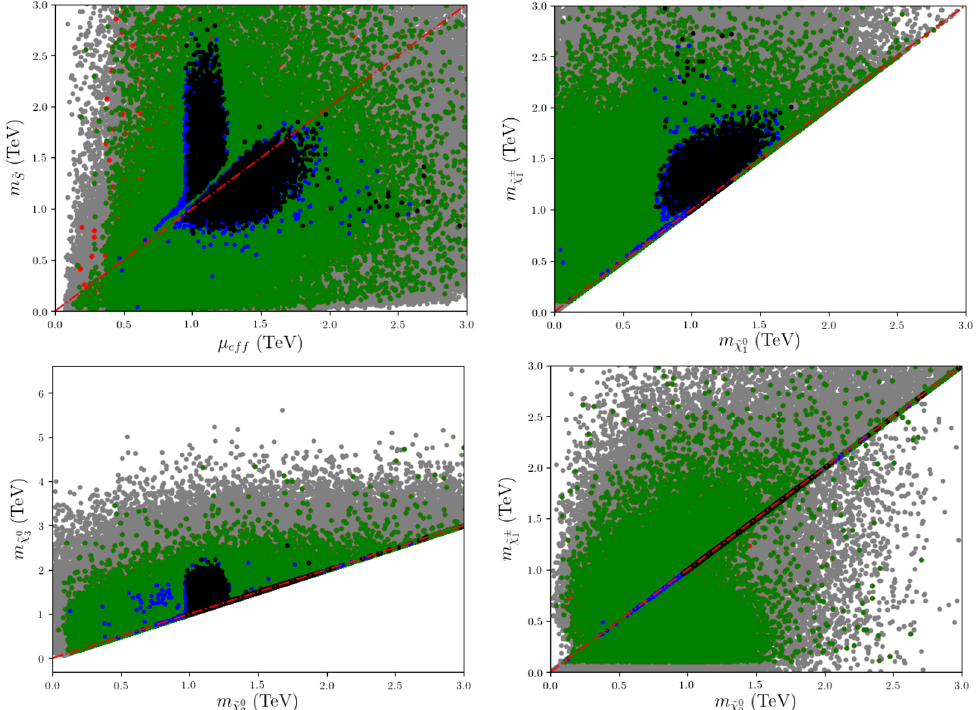
Figure 5 . The mass spectrum of chargino and neutralino states over the following planes: ( (cid:22) e(cid:11) ; m ~ (top left), ( m ; m ) (top right), ( m ~ (cid:31) 0 1 ~ (cid:31) (cid:6) 1 colour convention is as listed at the end of section